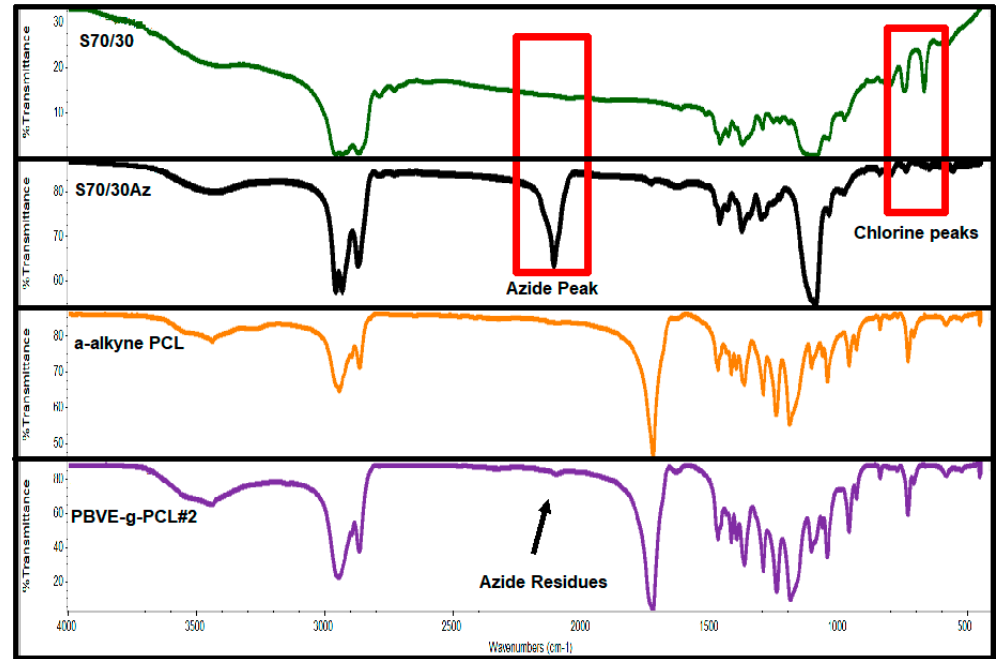
Figure 5. Monitoring the synthesis of sample PBVE– g –PCL#2 via the grafting “onto” methodology by IR spectroscopy.